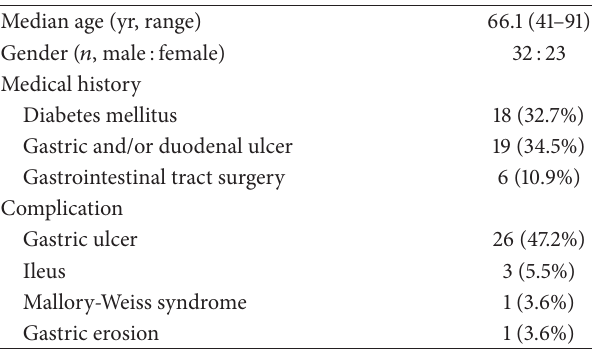
Table 1: Classification of bezoar and component. Table 2: Clinical characteristics of patients ( 𝑛 = 55 ).